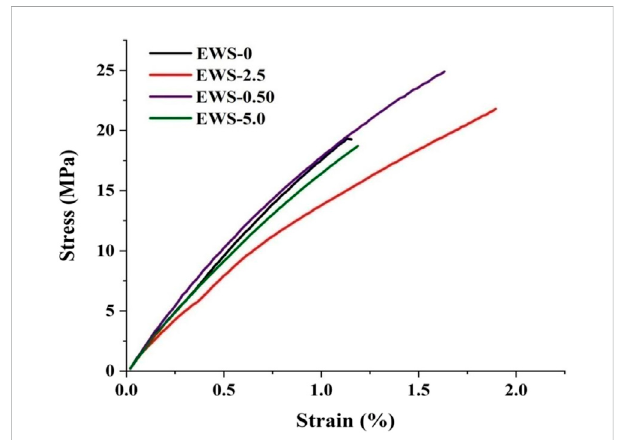
FIGURE 1 Stress-strain curve of wool-epoxy-nanosilica